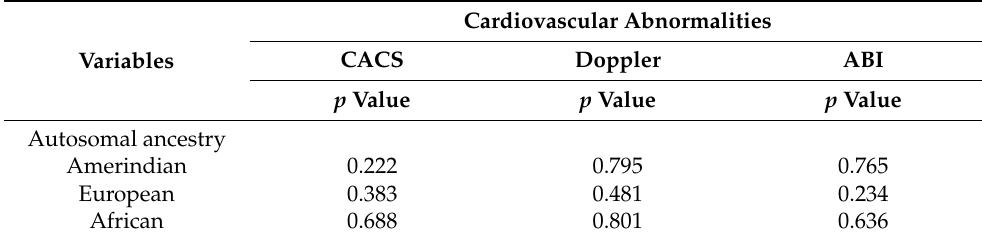
Table 5. Results of comparison tests ( p values) of autosomal ancestry data in individuals with type 1 diabetes according to a cardiovascular evaluation.